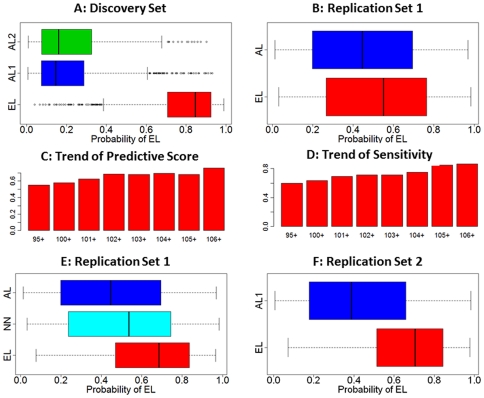
Discrimination of the classification rule based on the ensemble of 281 genetic risk models.
Panel A: Posterior probability of exceptional longevity (EL) and average longevity (AL) (x axis) in the centenarians (red boxplots) and controls (AL1: Illumina controls, blue boxplots, AL2: NECS controls, green boxplots) of the discovery set (NECS, top left). Both sensitivity and specificity were 89%. The boxplots in blue and green show that the distributions of the posterior probability of EL in the two control groups are not statistically different (p-value from t-test comparing the posterior probability of EL = 0.21). Panel B: Posterior probability of EL and AL (x axis) in the centenarians (red boxplots) and controls of the replication set 1. Sensitivity and specificity were 60% and 58% and the distributions of the predictive score are significantly different (t-test p-value = 0.001). Panel C: Median values of the posterior probability of EL (predictive score) in subsets of centenarians of the replication set 1 with increasing ages. The barplot shows that the median score increases with older ages. Panel D: Sensitivity of the classification rule in subsets of centenarians of the replication set 1 with increasing ages. The barplot shows the increasing sensitivity in older groups that reaches 85% in 20 subjects aged 106 and older. Panel E: Distribution of the posterior probability of exceptional longevity in the 253 cases of the replication set divided into two age groups (<103 years, pale blue, mean age 99 years, and ≥103 years, red, mean age 106). The sensitivities in the two groups are 57% and 71.4%. The three distributions are significantly different (p-value = 0.04 from t-test comparing Illumina controls and centenarians aged <103; p-value = 0.004 from t-test comparing the centenarians stratified by age). Panel F: Sensitivity and specificity in an additional set of 2863 controls from the Illumina database (blue), and an additional set of 60 centenarians that include 39 centenarians enrolled since June 2009 (mean age 108) and 21 centenarians that were excluded from older analysis because of genetic matching (mean age 106). The specificity in the additional Illumina controls is 61.2%. The sensitivity in the additional centenarians was 71.5% in the set of 21, and 82% in the additional 39 for a total of 78% (p-value from t-test comparing the posterior probabilities of EL in controls and centenarians <1e-10).